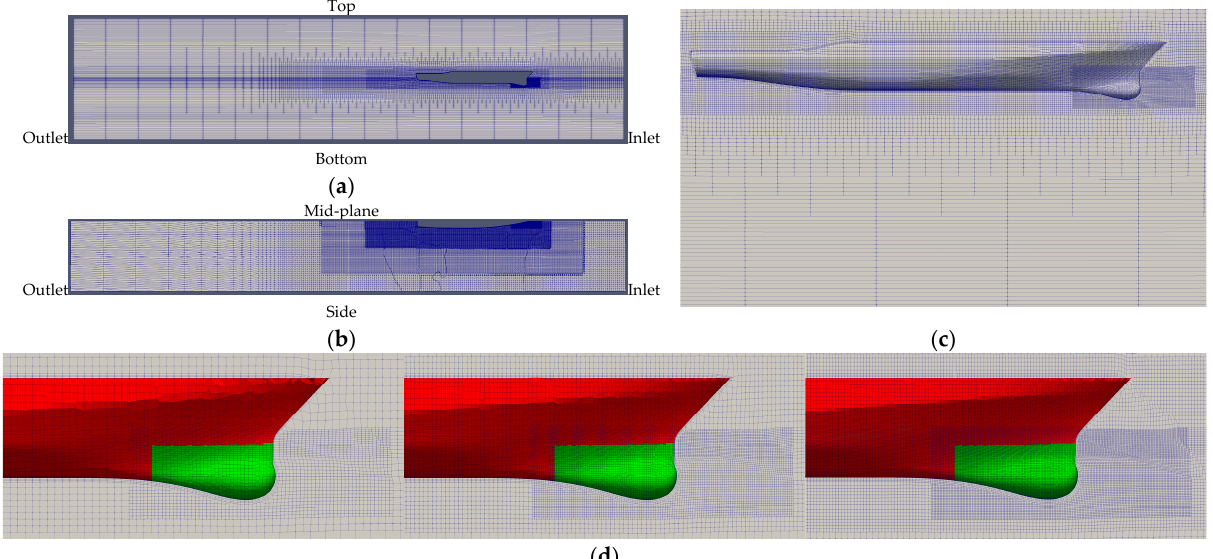
Figure 8. Grid topology. ( a ) Far-field grid distribution (size view), ( b ) far-field grid distribution (top view), ( c ) grid distribution around ship hull, ( d ) grid distribution around ship bow and sonar dome (Left to right: coarse, medium, fine grids). Table 1. Boundary conditions.